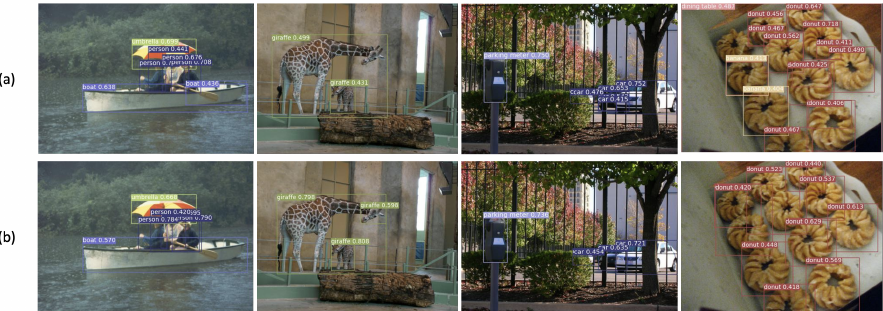
Figure 10. Detection results with the MS COCO2017 minival dataset by ( a ) the baseline FCOS and ( b ) the proposed method.